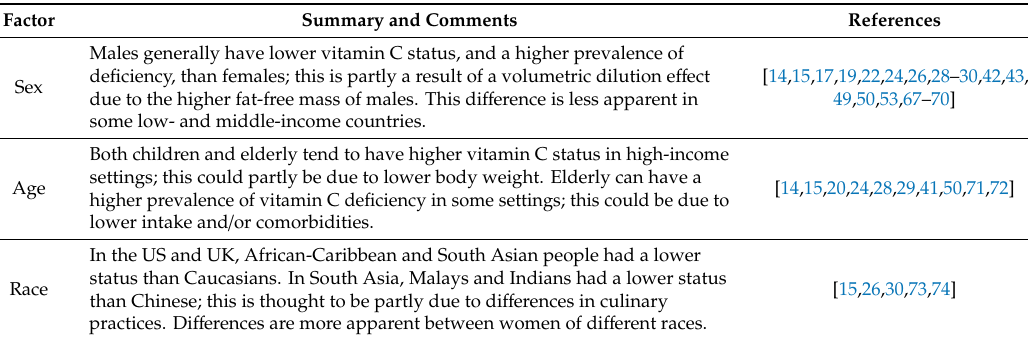
Table 4. E ff ect of demographic factors on vitamin C